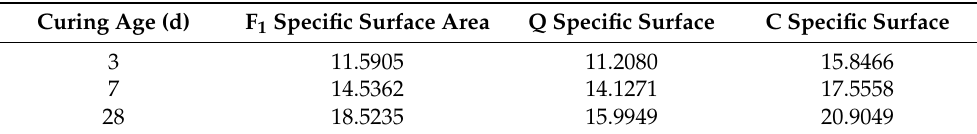
Figure 7. Distribution of different pores in the hardened pastes with ( a ) F1, ( b ) Q and ( c ) C at different ages. Table 3. F, Q, and C pore specific surface area (m 2